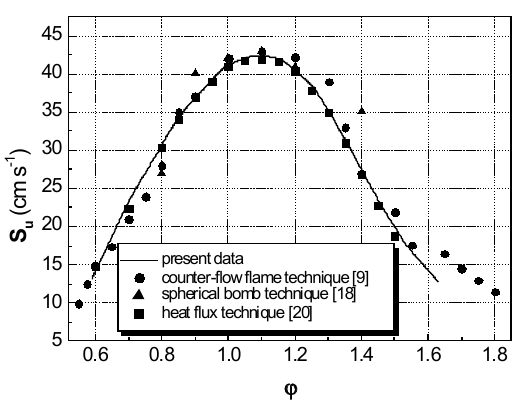
Figure 1. Computed burning velocities at 1 bar and 298 K and experimental data, from various literature